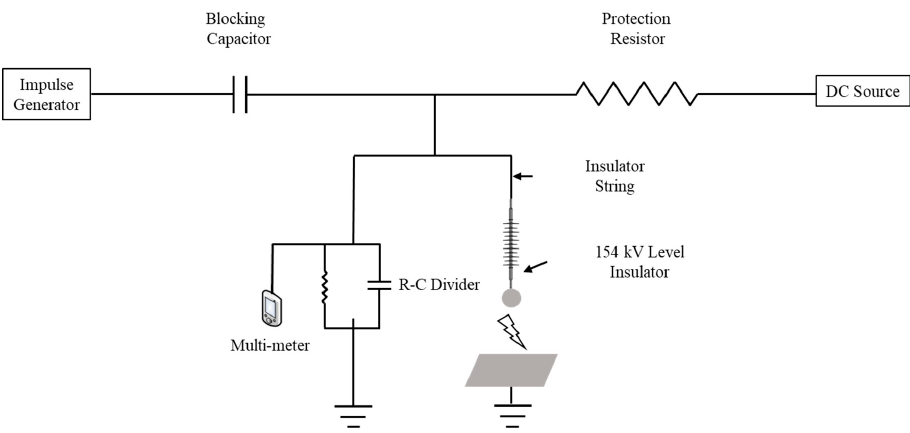
Figure 5. The circuit diagram of DC superimposed switching impulse experiment.